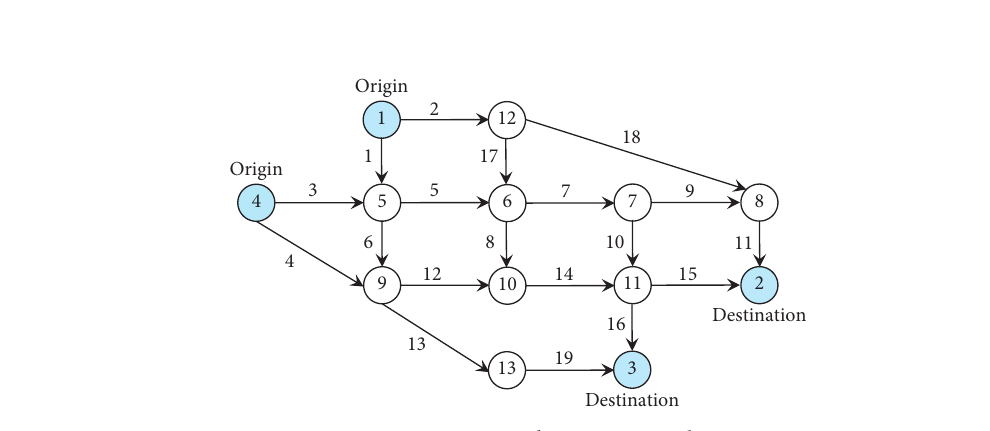
Figure 2: Nguyen and Dupuis